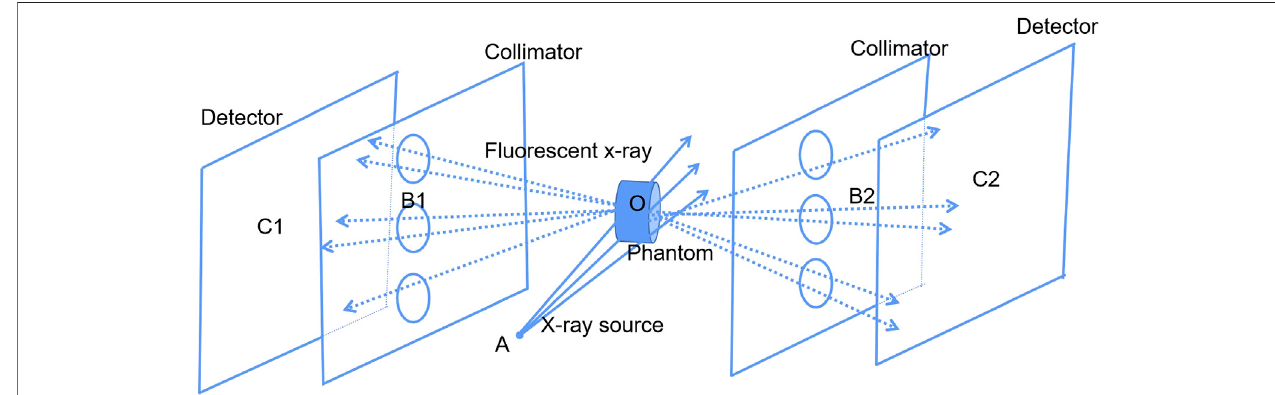
FIGURE 2 | Fast multi-pinhole collimated XFCT